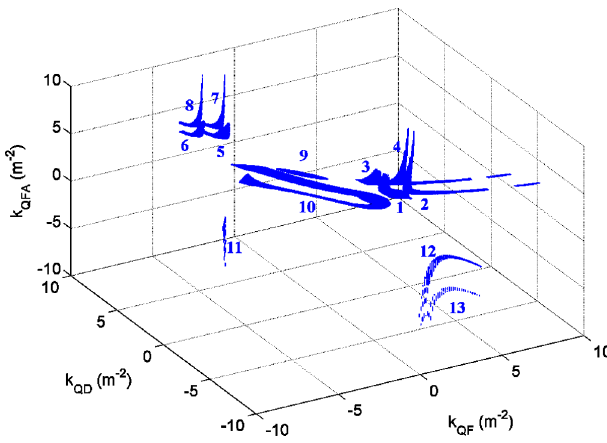
FIG. 2. (Color) All linear stable solutions in k -space for one of the 12 ALS TBA